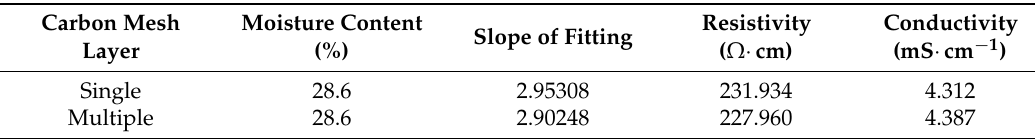
Table 4. Conductivity and resistivity calculated from the linear fitting slope of R s and distance from air-cathode in Figure 5.